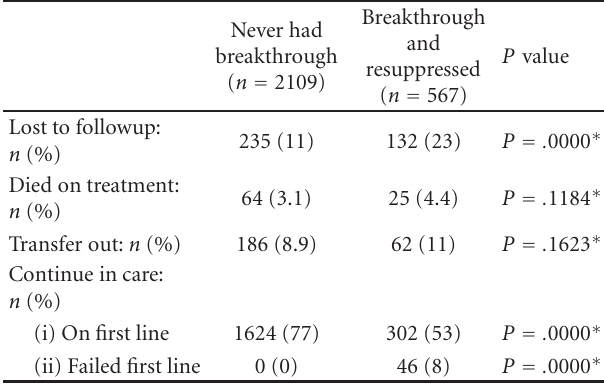
Table 2: Programmatic outcome of those who resuppressed com- pared to those who never experienced virological breakthrough. Breakthrough Never had and breakthrough resuppressed ( n = 2109)